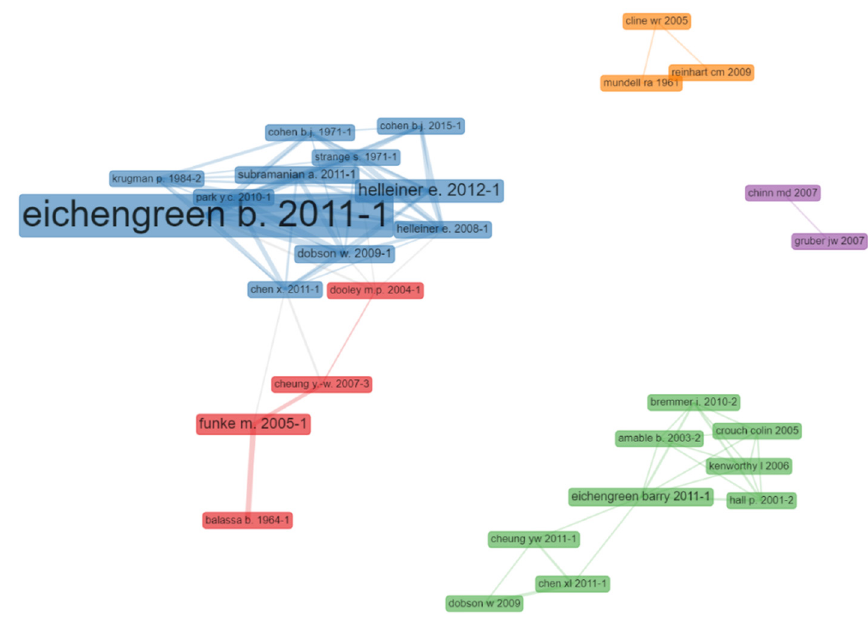
Figure 11. Co-citation network (by papers). Source: Authors’ elaboration using Biblioshiny.